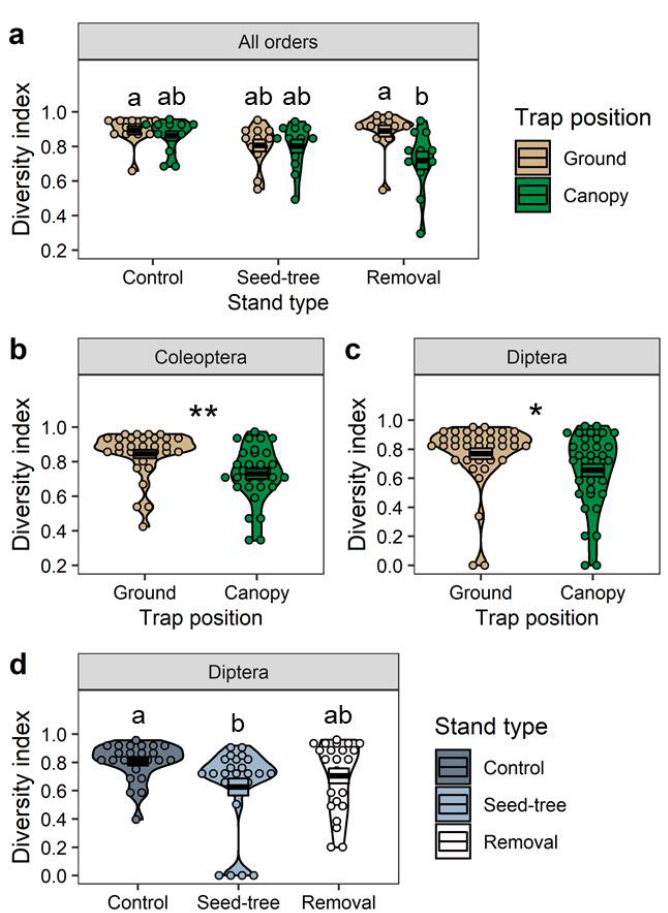
Figure 5. Crossbars (mean ± SE) and violin plots (probability density) of Simpson’s Index of Diversity. The significant interaction between trap position and stand type for all insect orders combined ( a ; p = 0.031), the significant main effect of trap position on Coleoptera ( b ; **, p < 0.01) and Diptera ( c ; *, p < 0.05), and the significant main effect of stand type on Diptera ( d ; p = 0.032). Mean values within panels ( a , d ) were compared using the Tukey – Kramer test with adjustment; groups with the same letter are not significantly different at α = 0.05.